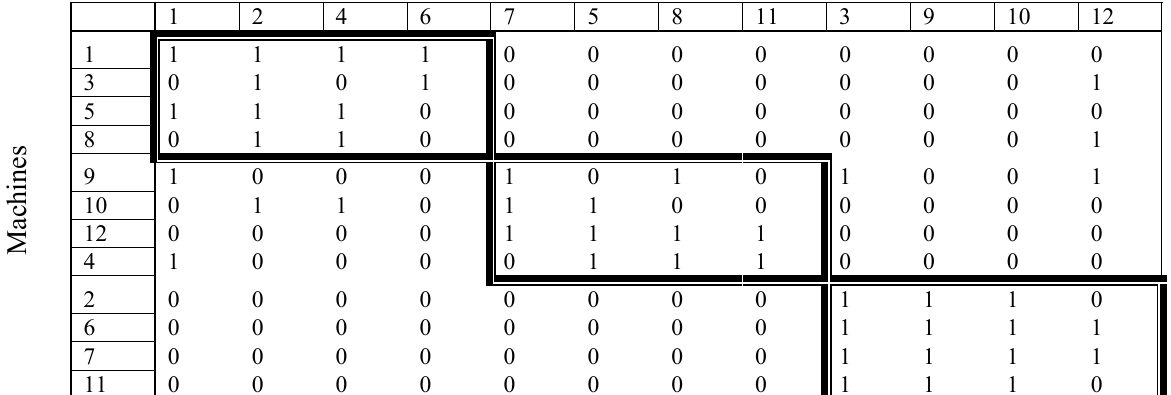
Final solution for illustration 1